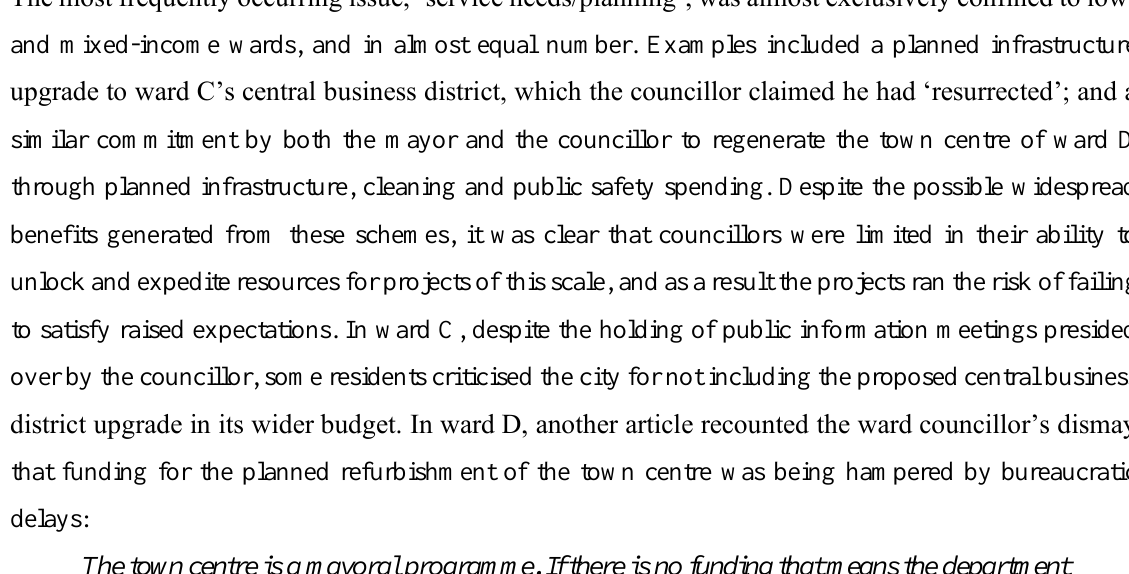
Service needs and